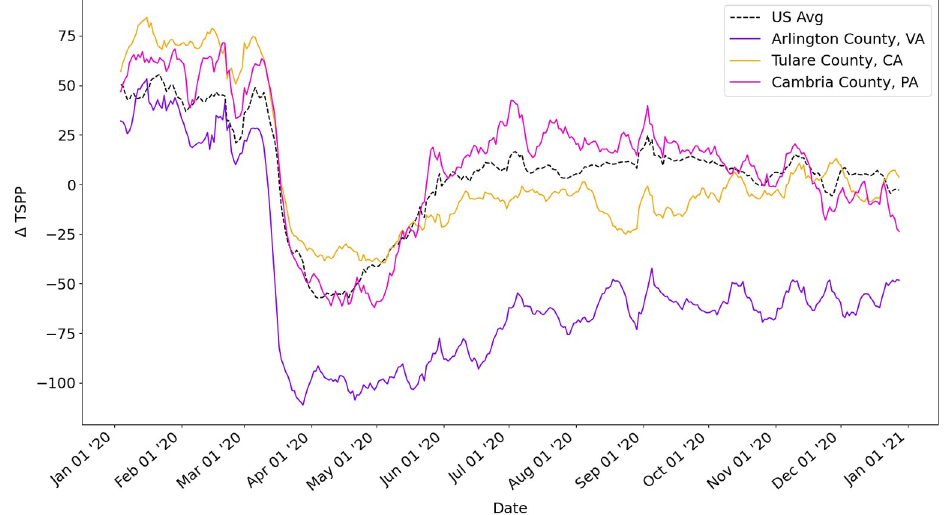
Fig 3. Δ TSPP calculated for the US, Arlington County (VA), Tulare County (CA), and Cambria County